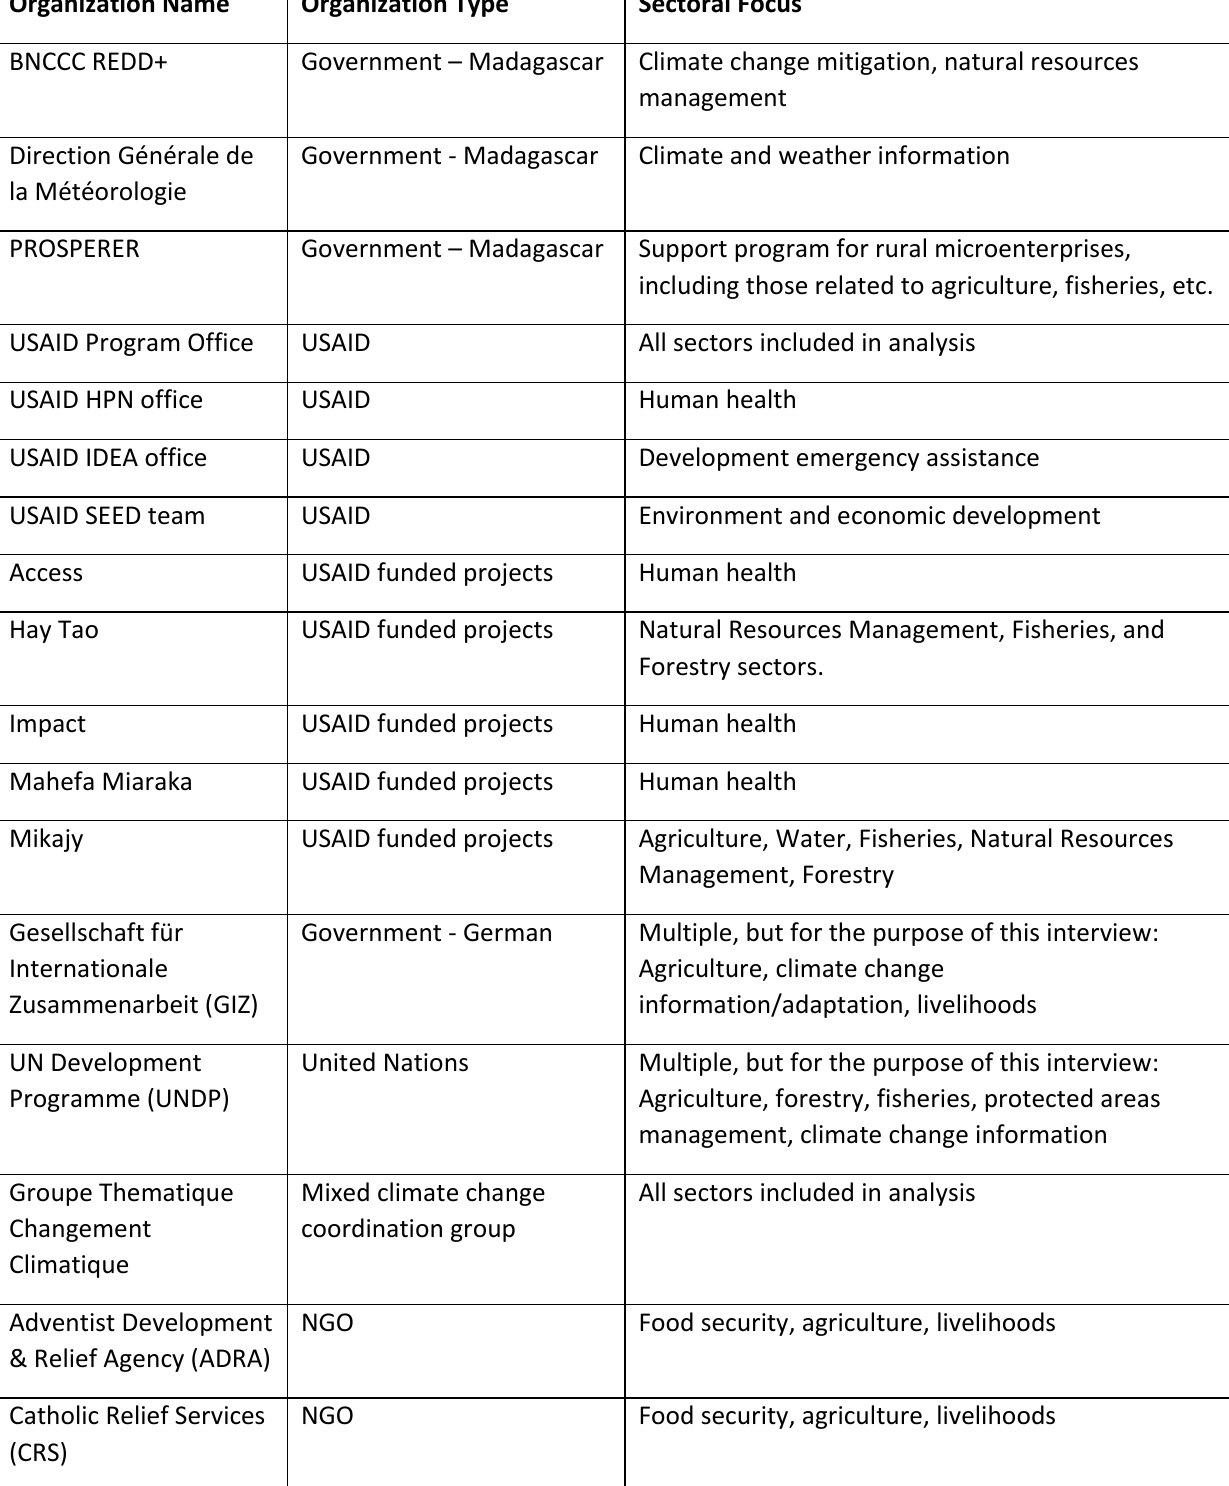
Table A1.1: Stakeholder organizations interviewed for this